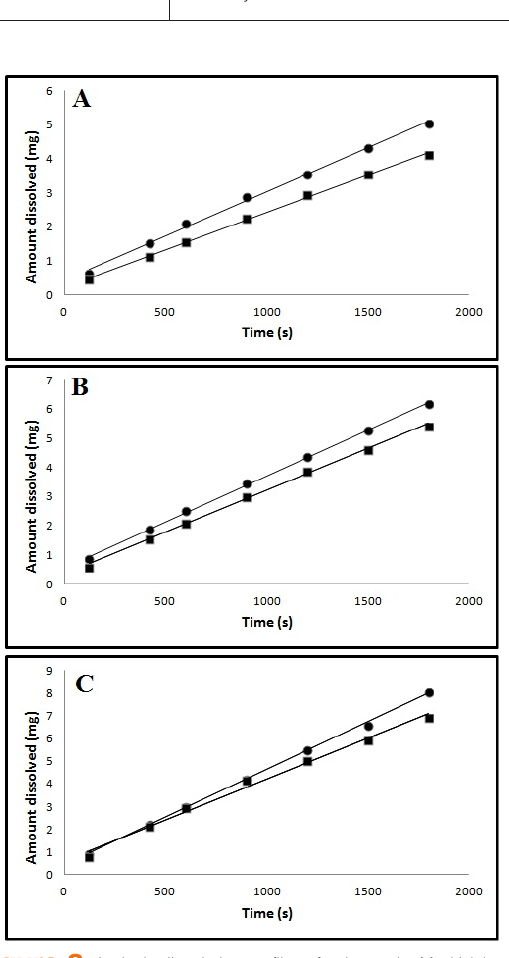
Figure 2. Intrinsic dissolution profiles of polymorphs Mod I ( ) and Mod II ( ) at 50 (A), 75 (B) and 100 (C) rpm.